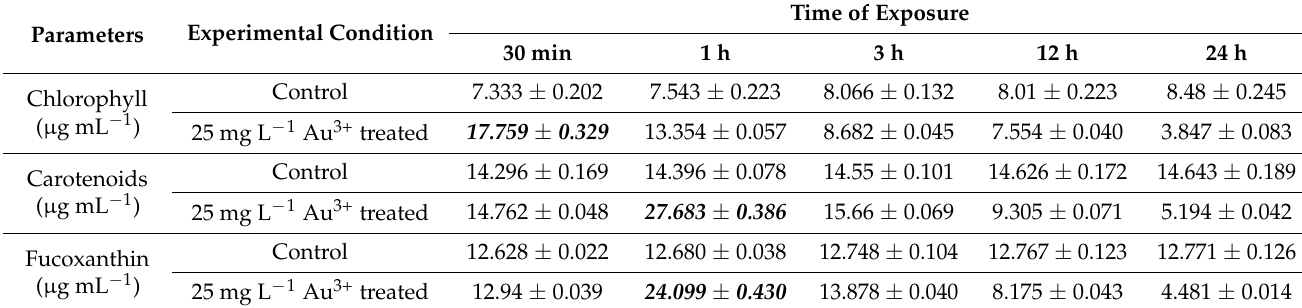
Table 2. The variation in chlorophyll, carotenoids and fucoxanthin content ( µ g mL − 1 ) in 25 mg L − 1 Au 3+ treated N. shiloi in different exposure times as compared to control (Maximum values (mean ± SE) are indicated as bold and italic).